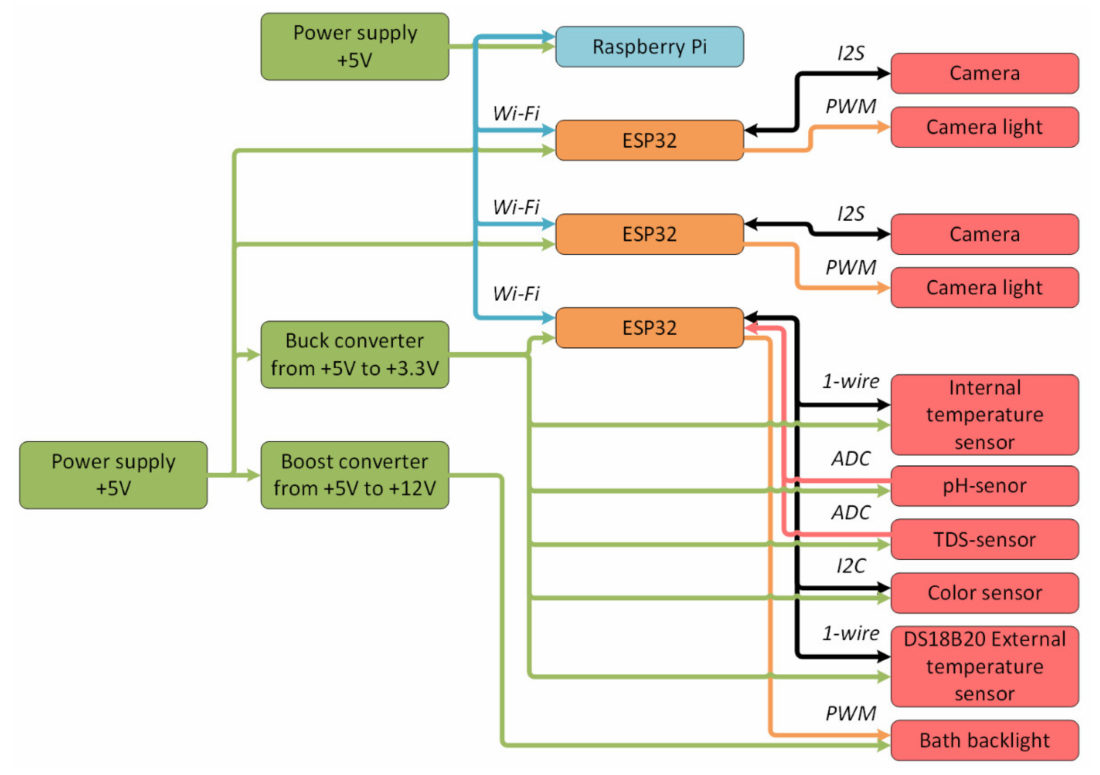
Figure 9. Block diagram of the digital production